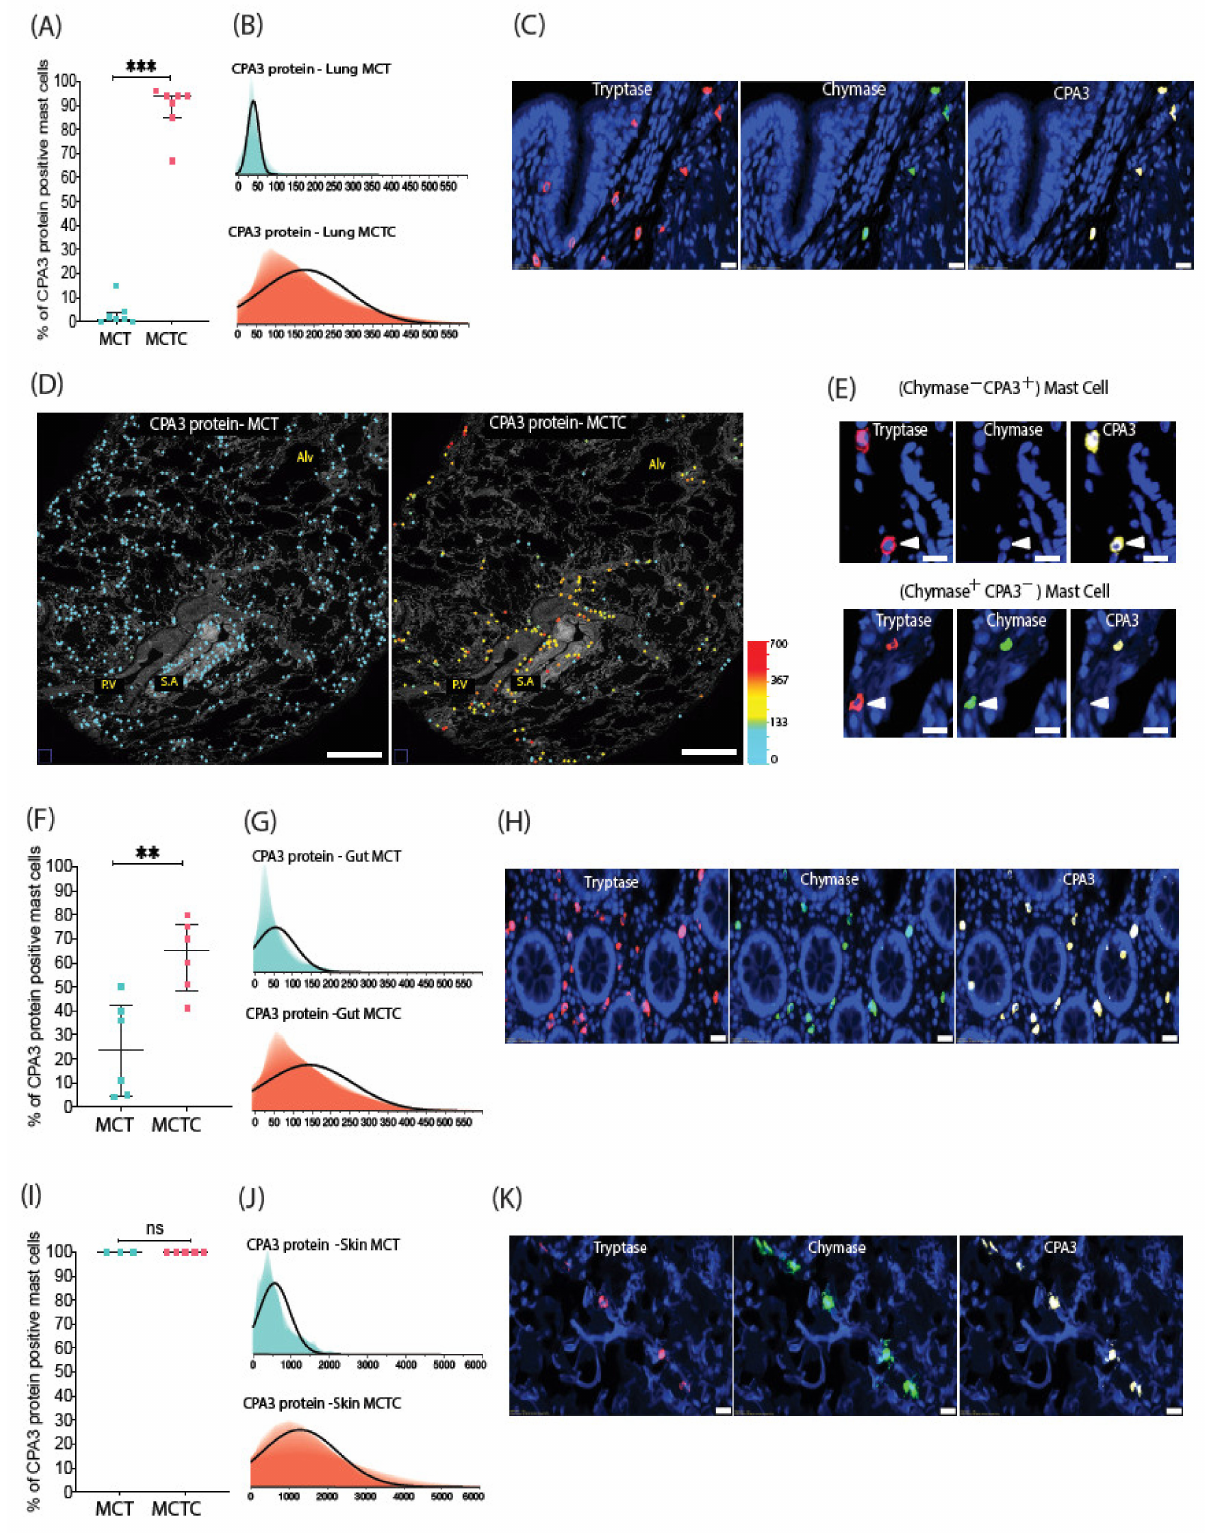
Figure 2. Mapping of CPA3 protein in MCT and MCTC populations. ( A ) Percentage of CPA3-protein-positive MCT and MCTC in lungs. Circles denote mean subject values ( B ) Shadowgrams (overlayed histograms with various X axis bin widths) exemplifying the cell frequency distribution across CPA3 protein intensity levels among 10 126 pooled individual MCT and MCTC cells ( C ) Immunofluorescence images showing the typical CPA3-positivity among lung MCTCs. ( D ) Low magnification micrographs displaying the spatial distribution of MCT and MCTC cells where cell x, y coordinates are